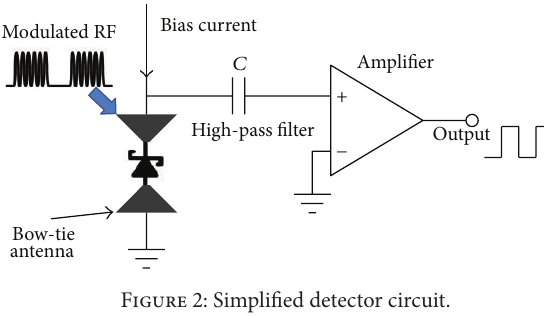
Figure 2: Simplified detector circuit.